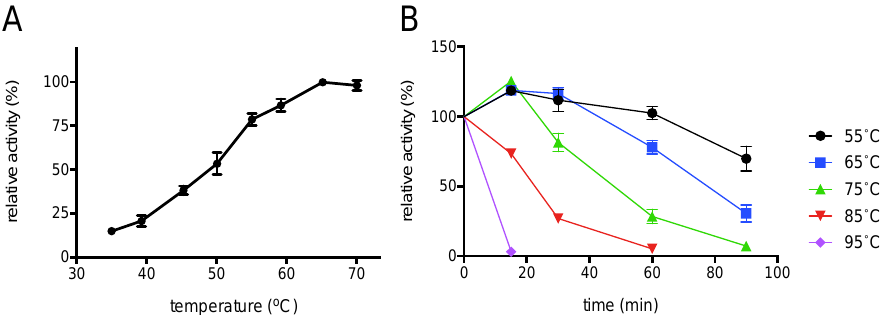
Figure 6. Effect of temperature on TaManD activity. ( A ) Optimum temperature of TaManD. ( B ) Thermostability of purified TaManD enzyme (1 µg) incubated over 90 min at various temperatures.